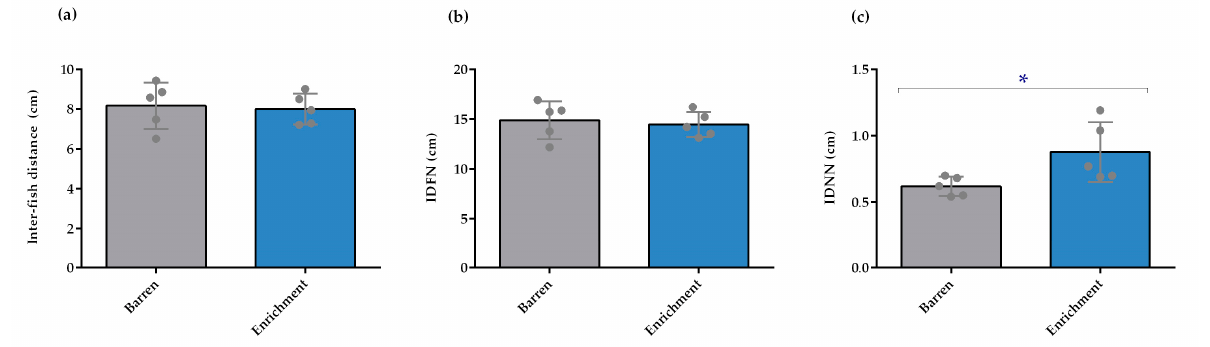
Figure 2. Shoaling behavior of adult zebrafish after exposure to barren and enriched conditions (n = 5). ( a ) Individual inter-fish distance (cm); ( b ) distance of the farthest neighbor (IDFN; cm); ( c ) distance of the nearest neighbor (IDNN; cm) of enriched and barren housed fish. Data are expressed as mean ± standard deviation. * p < 0.05 for comparison between housing conditions. Each point represents one experimental unit, i.e., a tank.